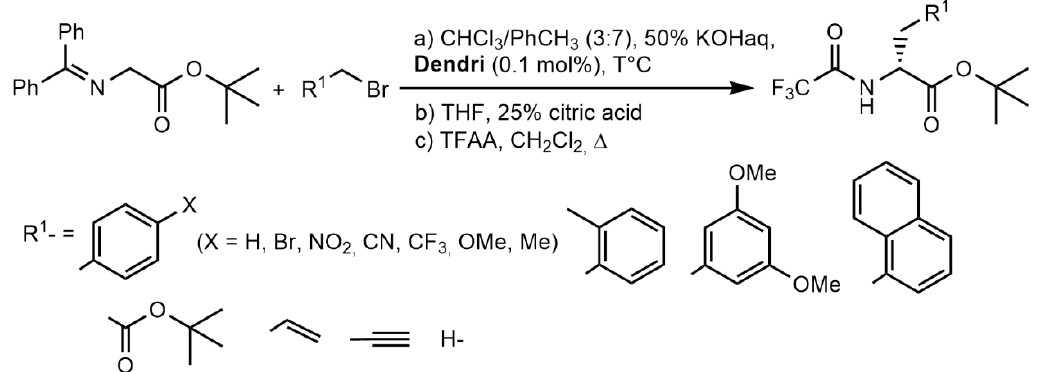
Figure 6. Asymmetric alkylation of a glycinate Schiff base with different types of bromides, in particular benzylbromide derivatives, organocatalyzed with the dendrimer functionalized with (+)-cinchonine, as shown in Scheme 6.